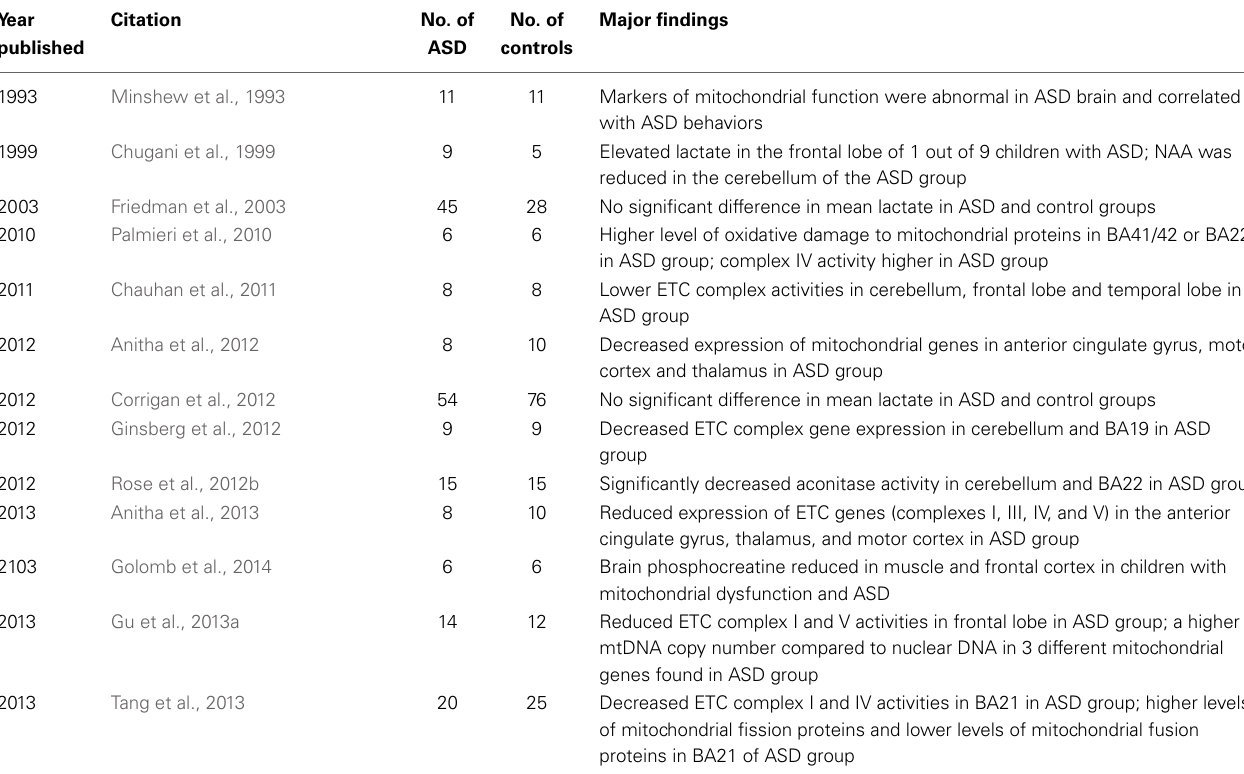
Table 2 | Studies of mitochondrial dysfunction in the ASD